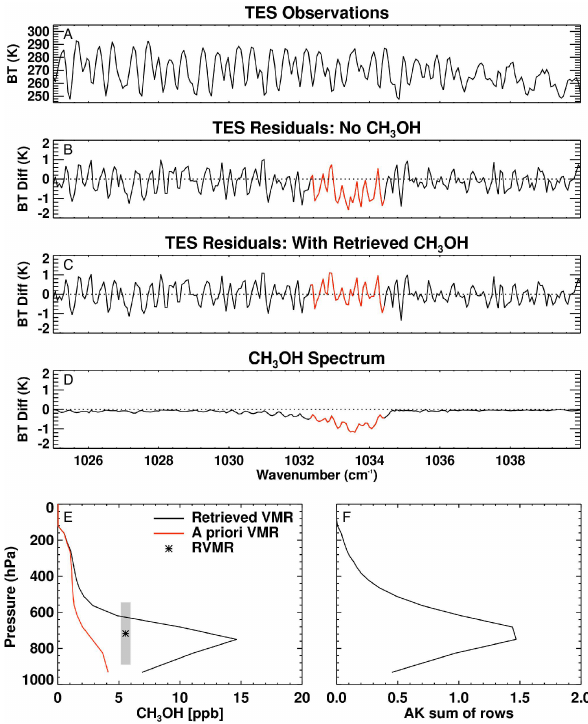
Fig. 1. An example TES methanol retrieval from 7 July 2008 (54.45 ◦ N, 113.05 ◦ W). (A) Spectral brightness temperature ob- served by TES. (B) Residuals between the TES measured spectrum and a modeled spectrum computed assuming a methanol-free atmo- sphere. (C) Measurement-model residuals after three iterations of the forward model to optimize the methanol profile. (D) Difference between the second and third panels, showing the brightness tem- perature signal associated with methanol. In each case the spectral range used for the retrieval is shown in red. (E) The corresponding retrieved methanol profile (black line), a priori profile (red line), and the representative volume mixing ratio (RVMR, black symbol) for this example. The shaded bar indicates the vertical range over which the RVMR applies, corresponding to the full width at half- maximum of the averaging kernel peak. (F) The sum of rows of the averaging kernel for this